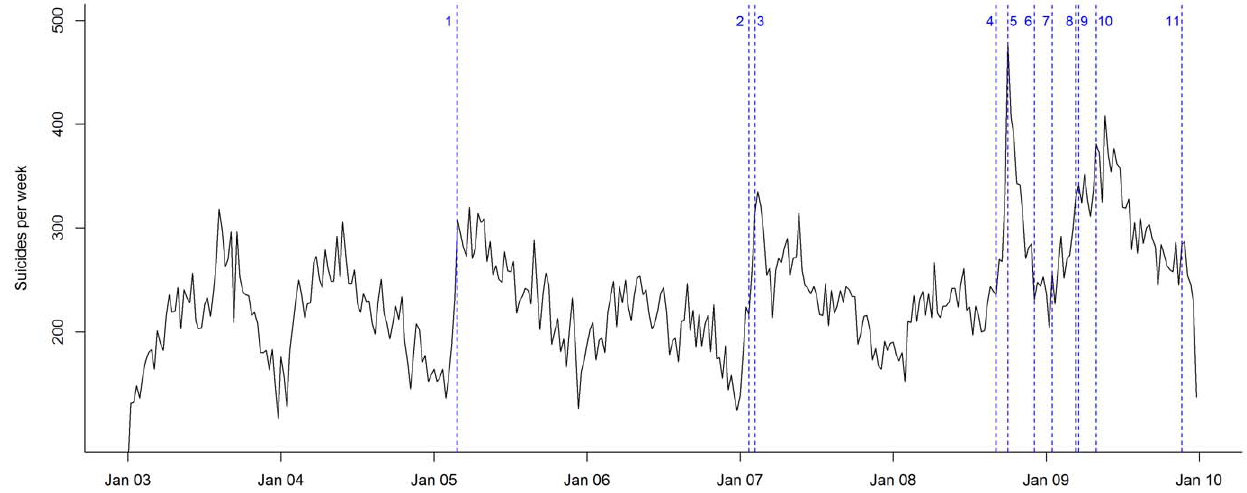
Figure 1. Overall suicide counts in South Korea between 1 January 2003 and 31 December 2009. Remarks: The vertical dashed lines marks the week in which a celebrity died.